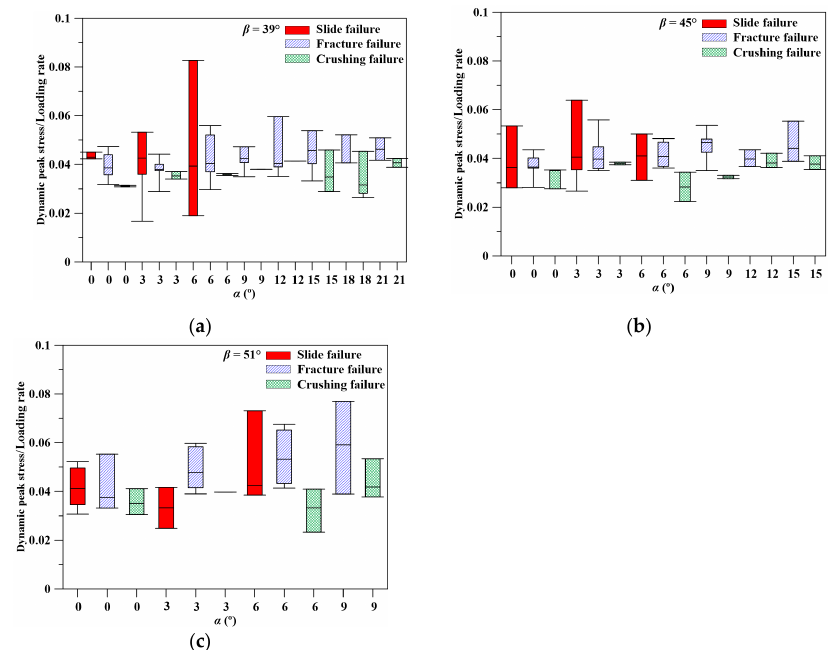
Figure 12. Box-and-whisker plot of ratio of dynamic peak stress to loading rate (DSLR) at various angles, α , for specimens with β = 39°, 45°, and 51°( a – c ).